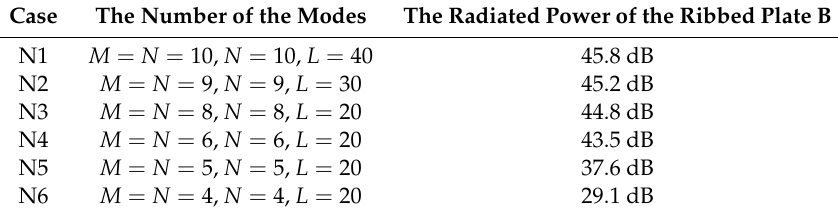
Table 2. The variation trend of the radiated power of the ribbed plate B (at 500